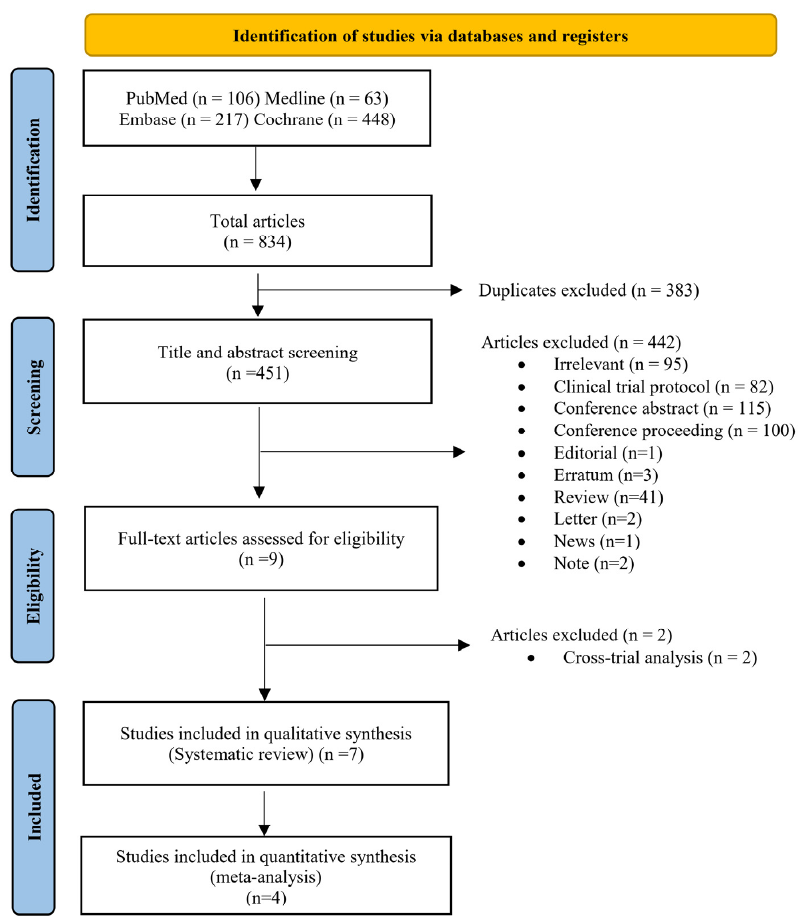
Figure 1. PRISMA flowchart summarizing the study selection Figure 1. PRISMA fl owchart summarizing the study selection process.